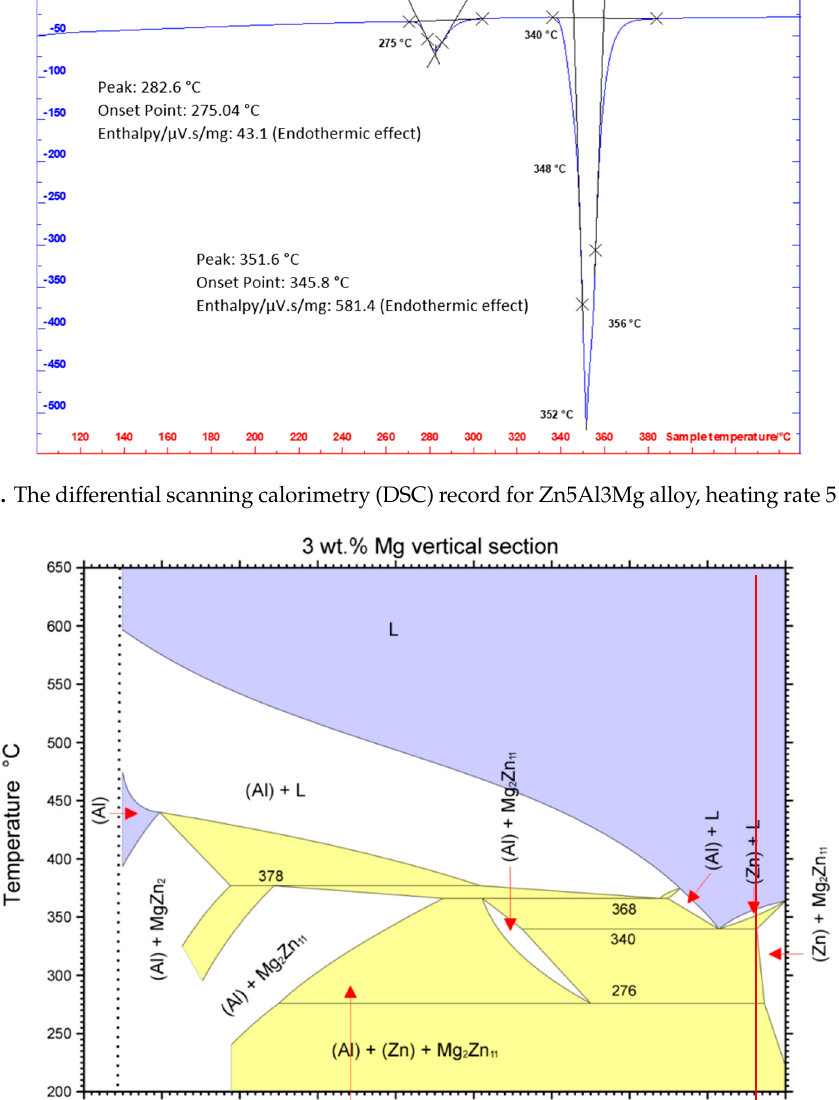
Figure 6. The differential scanning calorimetry (DSC) record for Zn5Al3Mg alloy, heating rate 5 °C/min.